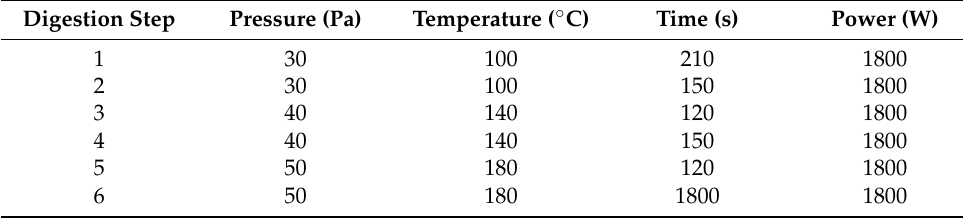
Table 2. Digestion procedure of the leaves Table 2. D igestion procedure of the leaves sample.